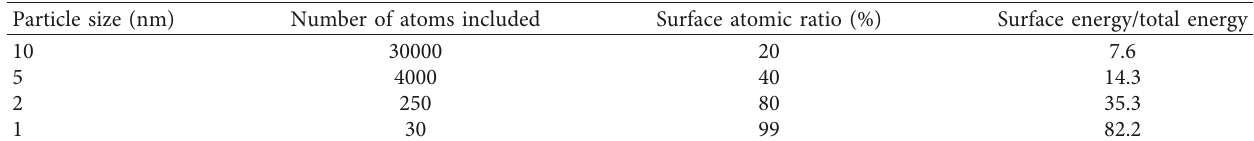
Table 2: Relationship between nanoparticle size and surface atomic number.